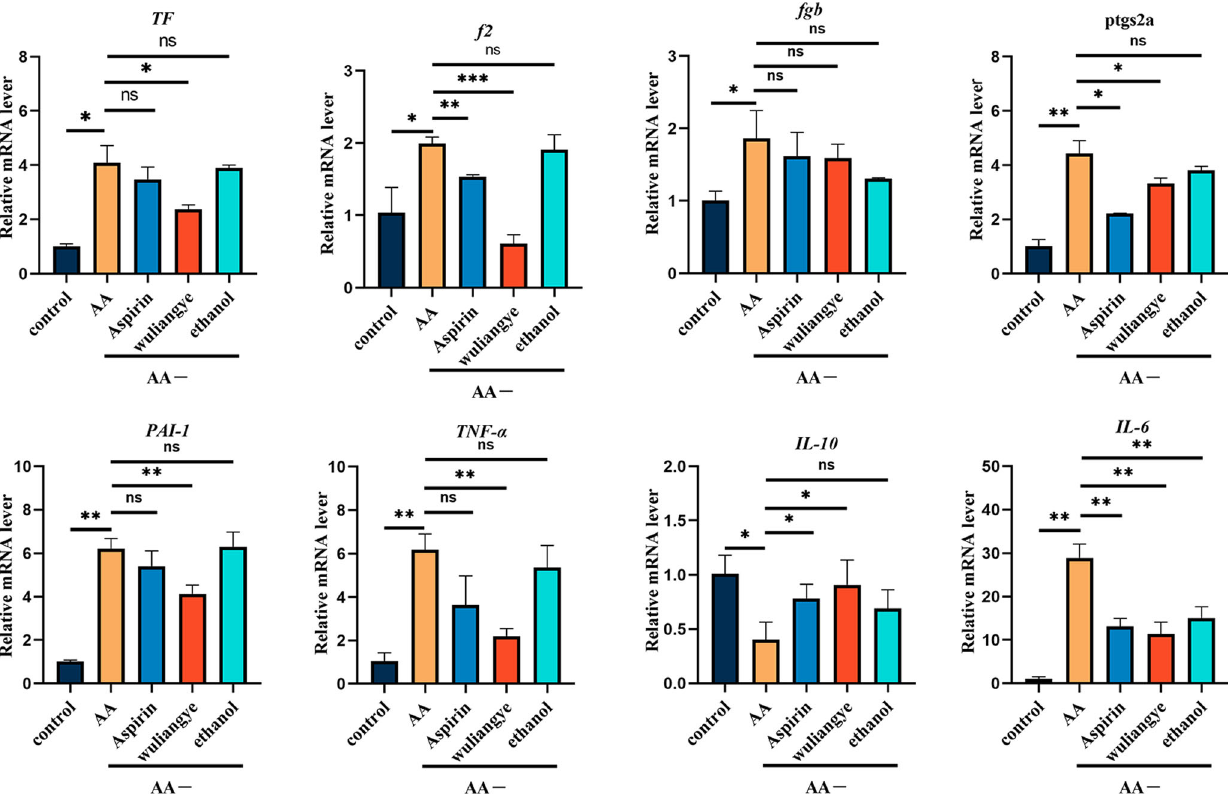
Fig. 4 Changes of thrombus-related gene expression. Compared with the control group; compared with the model group; data are presented as mean ± standard deviation (ns for not signi fi cant, * P < 0.05, ** P < 0.01, *** P < 0.001, t